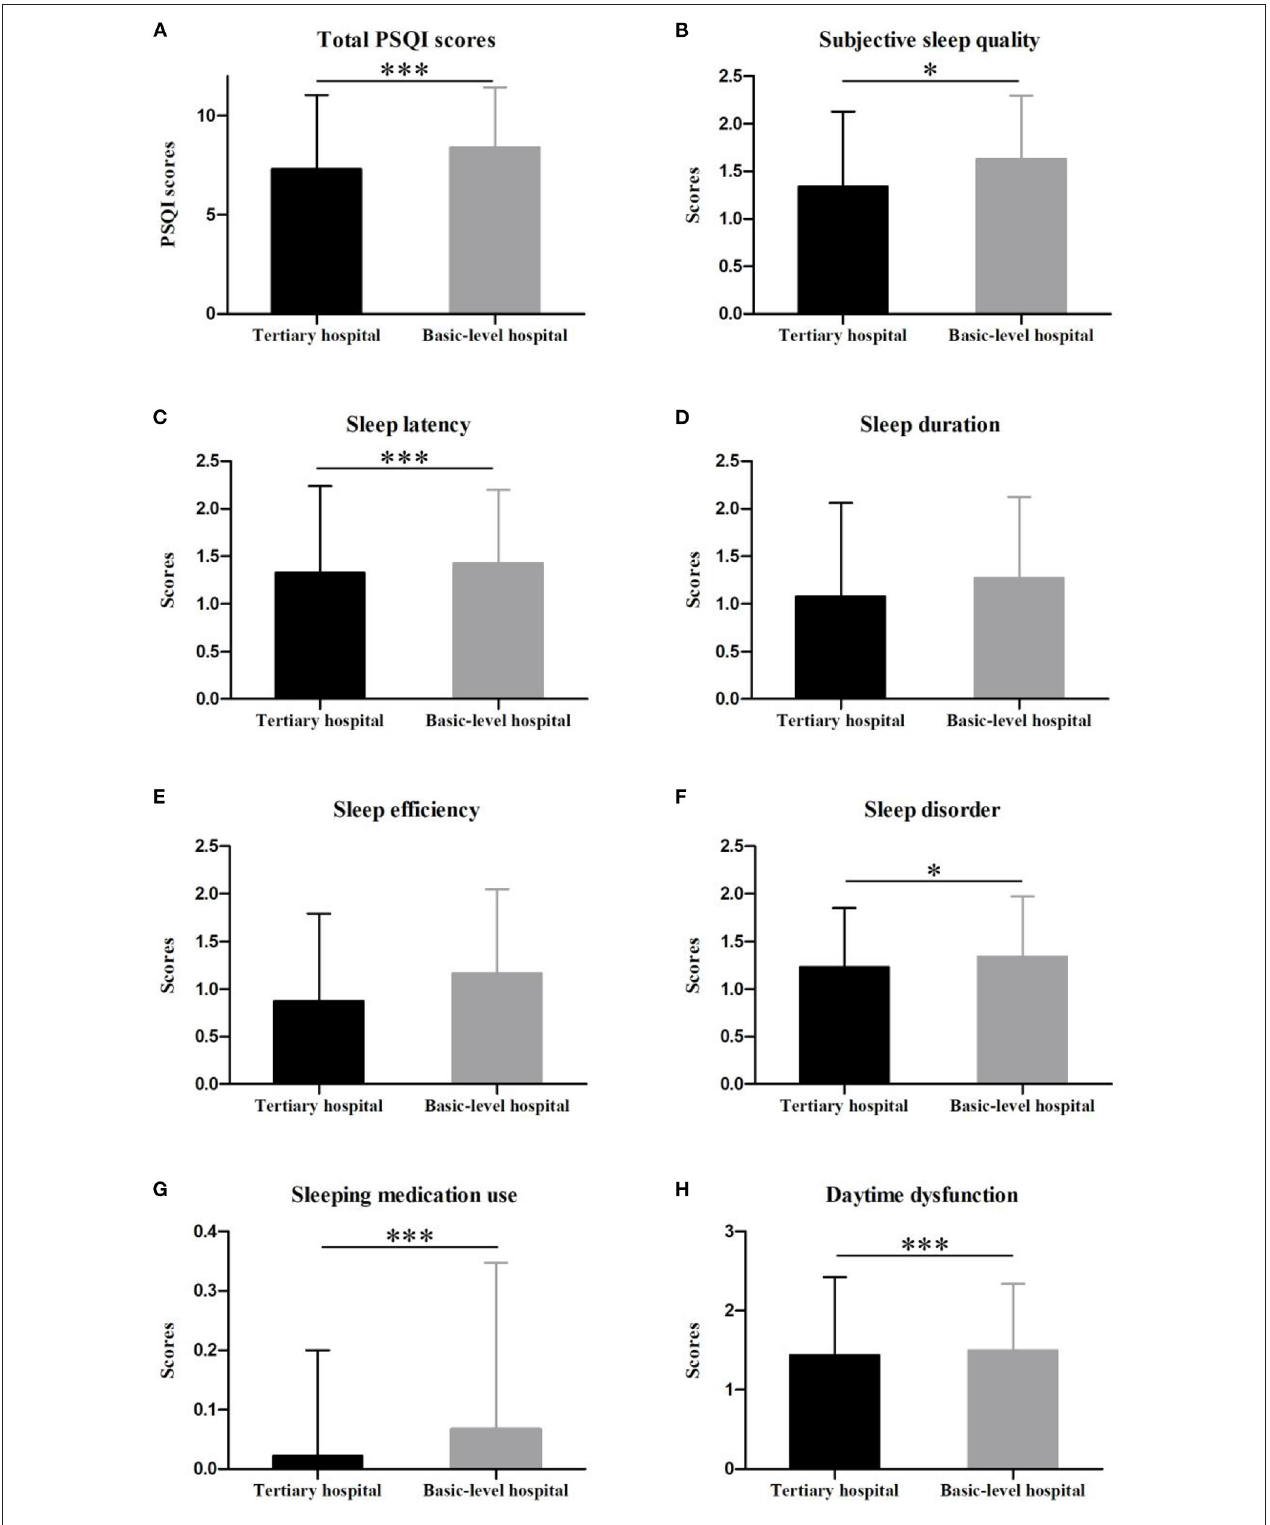
FIGURE 3 | Comparison of groups in terms of the total Pittsburg Sleep Quality Scale Score (A) and subscale scores (B–H) (*** p < 0.001, * p < 0.05).